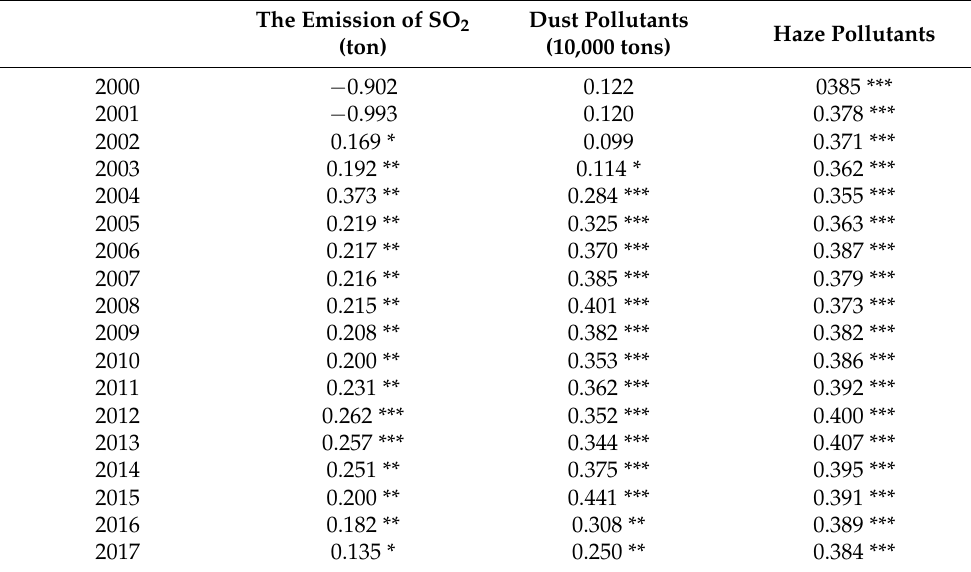
Table 3. Spatial autocorrelation